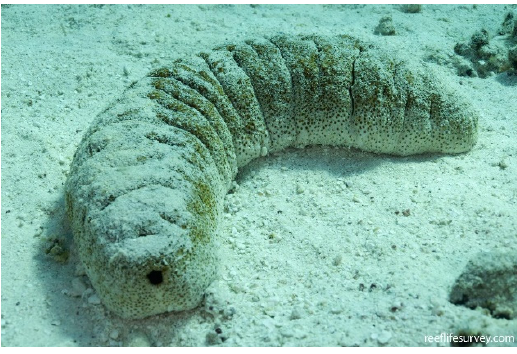
Figure 28. A specimen of Stichopus herrmanni . © Andrew Green; https: // reeflifesurvey.com / Figure 28 . A specimen of Stichopus herrmanni . © Andrew Green; https://reeflifesurvey.com/.